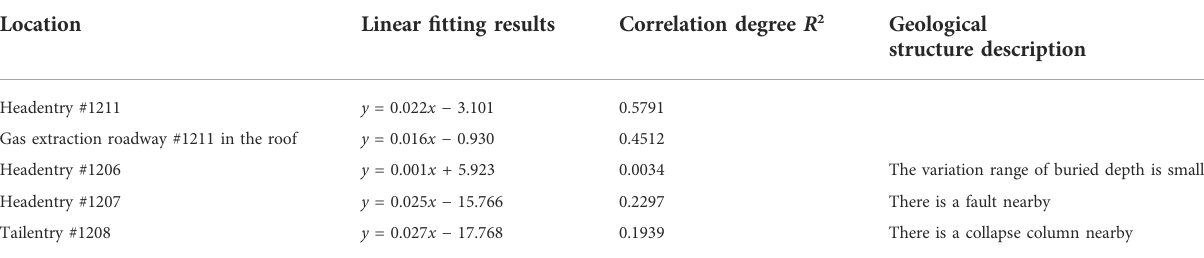
TABLE 1 Linear regression relationship between the gas content and buried